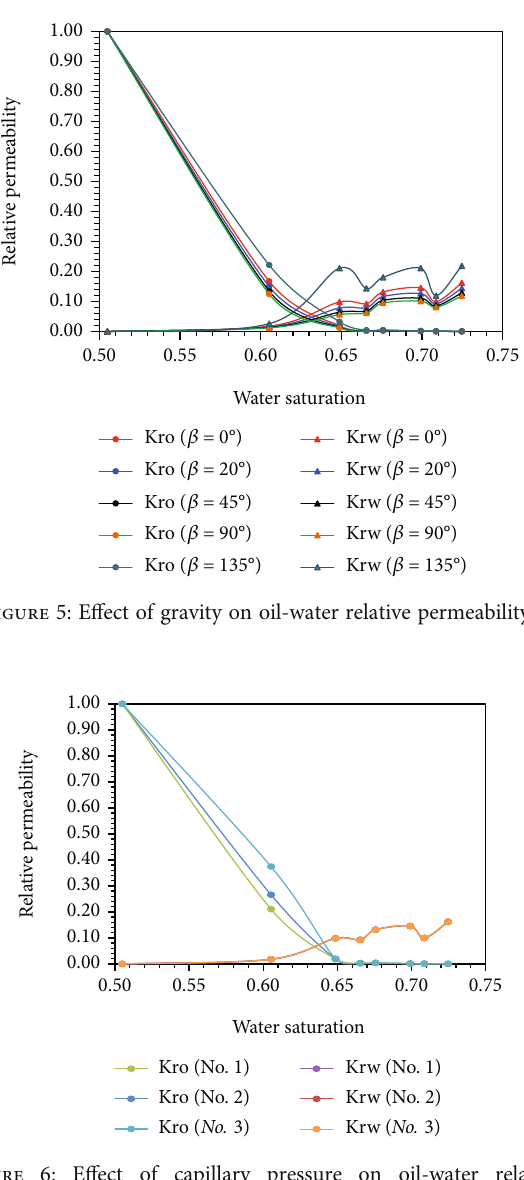
Figure 6: E ff ect of capillary pressure on oil-water relative